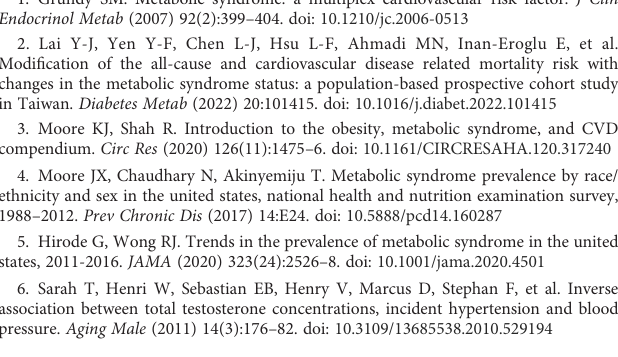
SUPPLEMENTARY FIGURE 1 Distributionof TTby age. Thespotrepresents eachobservation, andthe redline is estimated by spearman correlation.TT, total serum testosterone level. SUPPLEMENTARY FIGURE 2 The association between TT and MetS among participants who were not taking antidiabetic drugs, hypertension medication or lipid-lowering medication with logistic regression. The green spot and lines represent the odds ratios (OR) and 95% con fi dence interval of OR. Model adjusted for race, education level, marital status, ratio of family income to poverty, BMI, alcohol use, smoking-cigarette use, depression, sleep disorders, total caloric intake per day, and NLR. TT, total serum testosterone level; MetS, metabolic syndrome; BMI, body mass index; NLR, neutrophil-to-lymphocyte ratio. SUPPLEMENTARY FIGURE 3 The association between TT and MetS among participants without ovary removed by logistic regression. The green spot and lines represent the odds ratios (OR) and 95% con fi dence interval of OR. Model adjusted for race, education level, marital status, ratio of family income to poverty, BMI, alcohol use, smoking-cigarette use, depression, sleep disorders, total caloric intake per day, and NLR. TT, total serum testosterone level; MetS, metabolic syndrome; BMI, body mass index; NLR, neutrophil-to-lymphocyte